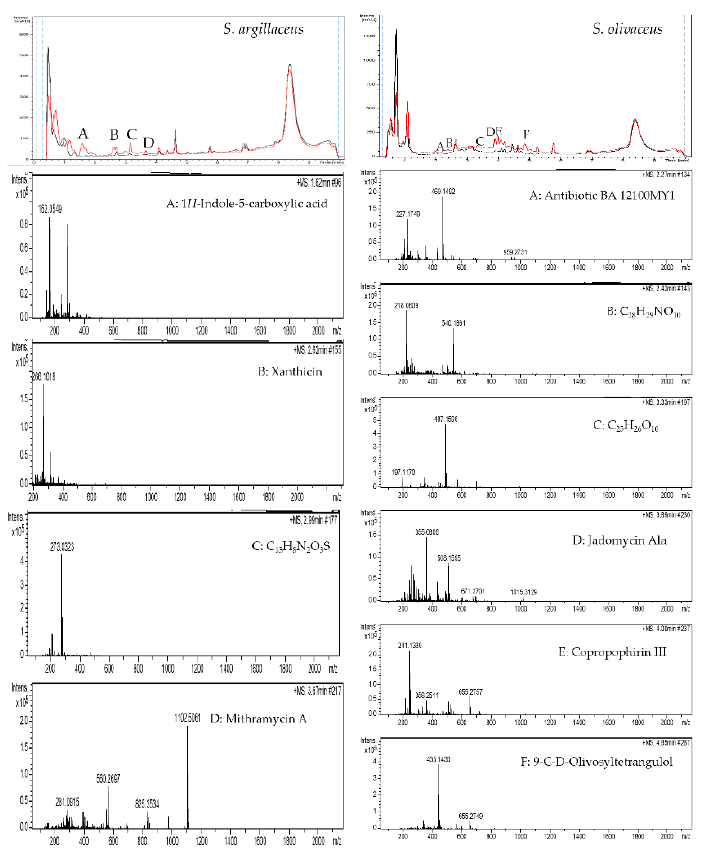
Figure 3. Analysis of the metabolites produced by S. ambofaciens ( left ) and by S. griseus subsp. griseus ( right ) grown in YEPD with water (black) or with SAP (red). Mass spectra of compounds in the differential peaks.